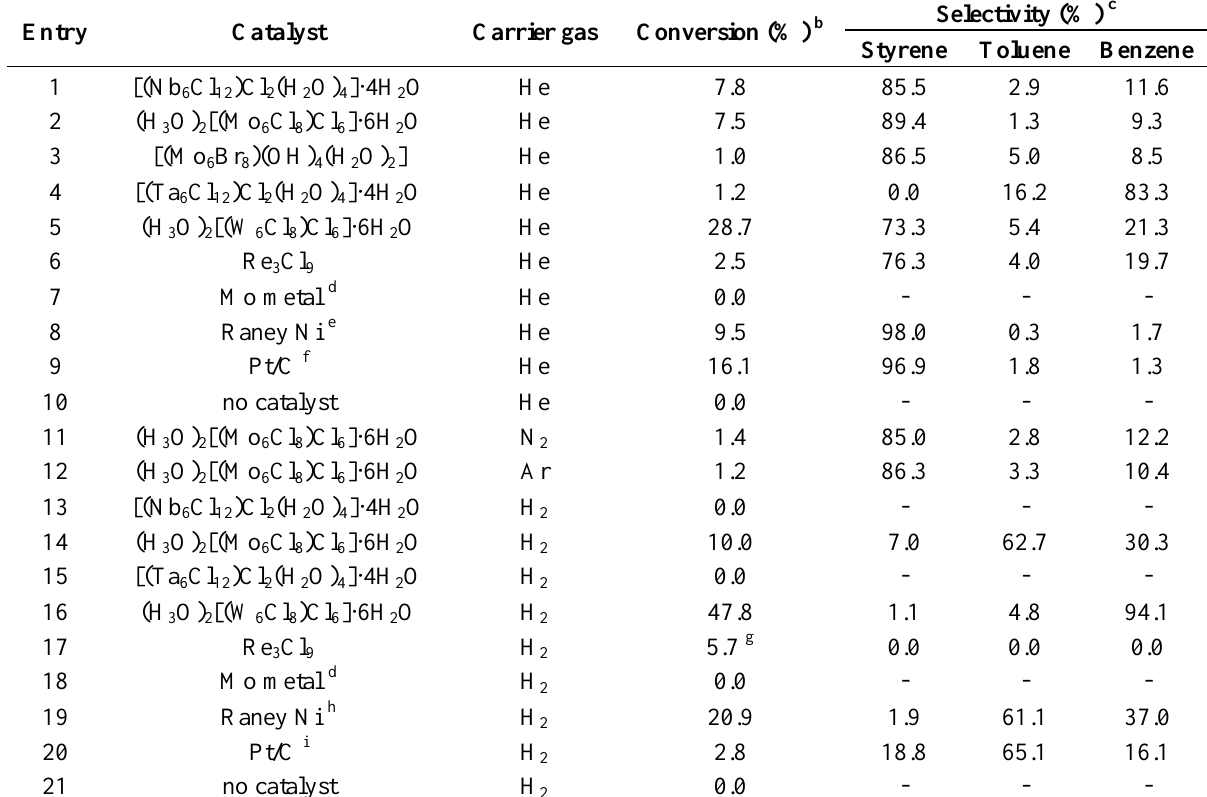
Table 2. Dehydrogenation and reductive dealkylation of ethylbenzene over halide clusters a